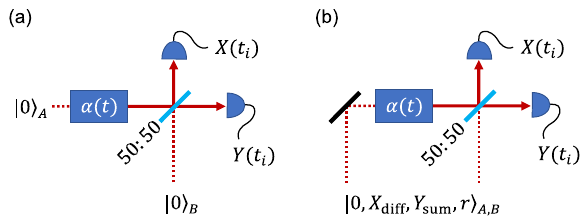
Fig. 1 Monitoring of quantum state displacement α ( t ). The phase space observables are the real and imaginary parts α ð t Þ ¼ h ^ X ð t Þi þ i h ^ Y ð t Þi . a The simultaneous (semi-classical) monitor- ing of the displacement is hampered by quantum uncertainty, which can be illustrated by ground states entering the measure- ment device at inputs A and B . b Exploiting an entangled state 0 ; X diff ; Y sum ; r j i A ; B reduces the quantum noise imprecision of a single measurement pair ( X ( t i ); Y ( t i )) at time t i in principle to arbitrarily low values. Here, ‘ 0' refers to the average displacements at inputs A and Y r to the joint B , X diff , sum to the kind of quantum correlations, and strength of the quantum correlations. In practice, decoherence on the entangled state that reduces r is the major problem.